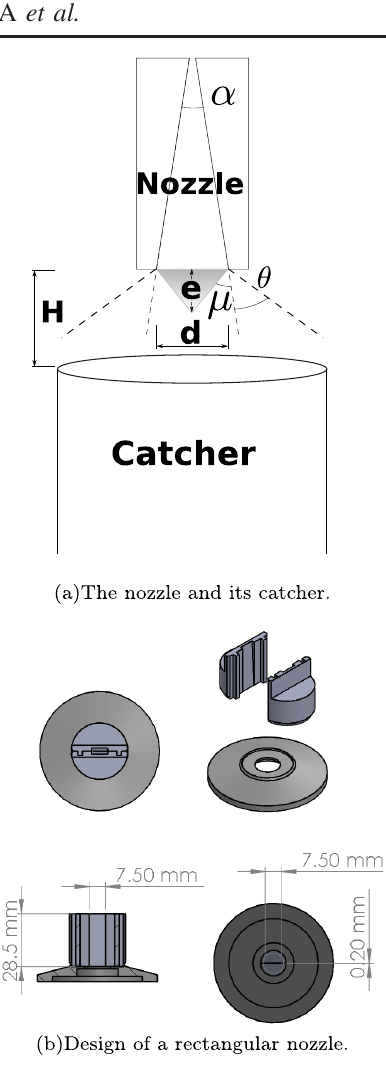
FIG. 4. (a) Layout of the nozzle and its catcher (see the text for details). (b) Construction sketches of the nozzle pieces with dimensions.